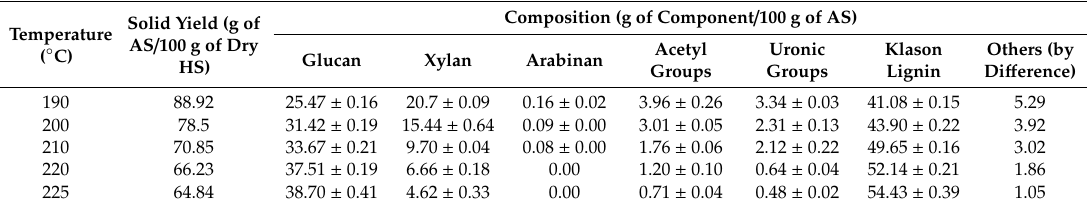
Table 2. Solid yields (measured as g of oven-dry AS / 100 g of oven-dry HS) and composition of AS (measured as g component / 100 g of oven-dry AS) obtained in experiments performed up to the desired temperatures. The results are reported as the average of triplicate measurements ± standard deviation.